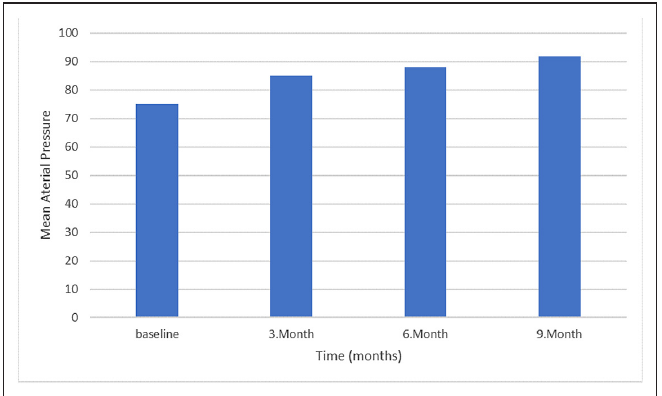
Figure 6. Temporal change of mean arterial pressure ( P =